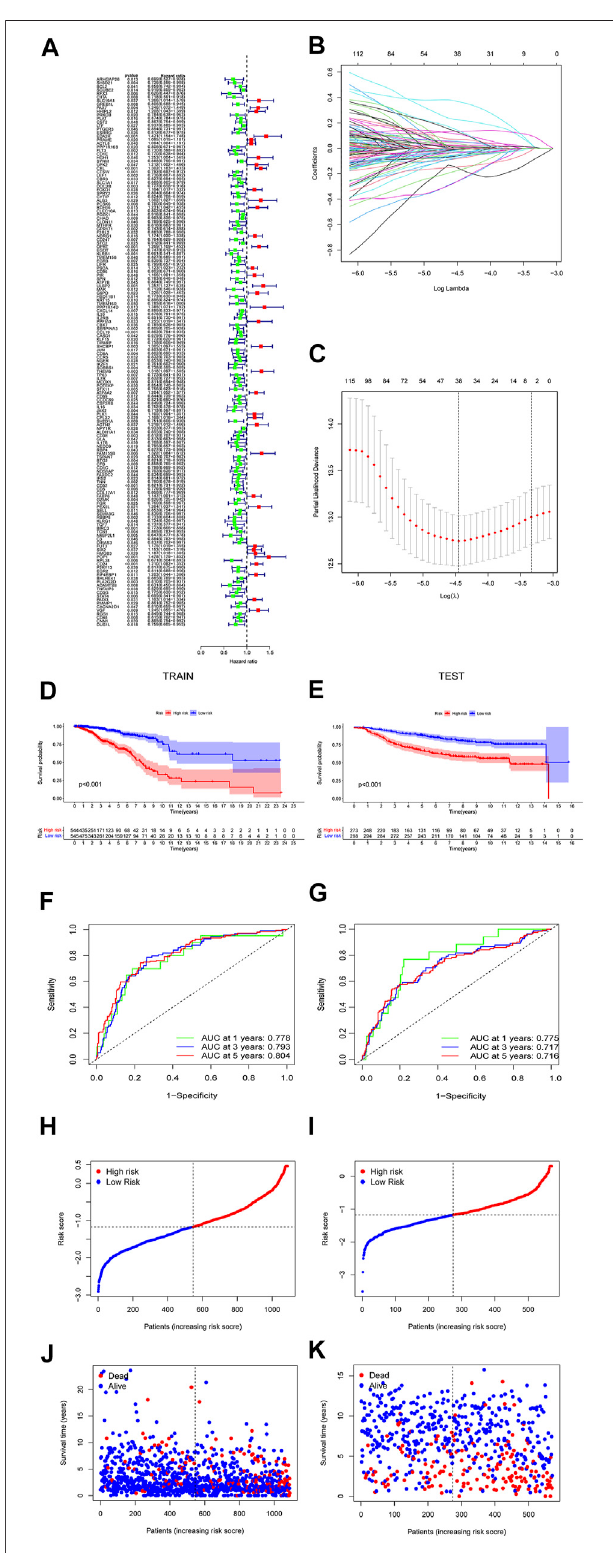
FIGURE 4 | Lasso regression analysis and Lasso regression model reduced variable (B,C) . Kaplan – Meier curves of OS in the high-risk and the low-risk groupsstrati fi edbythenecroptosis-relatedsignatureinthecohorts (D,E) .The number of patients in different risk groups. The ROC analysis of OS for the signature at 1 year, 2 years, and 3 years (F,G) . The number of patients in different risk groups. Survival status of patients in different groups (H,I) . Survival status of the test patients in different groups (J,K) .